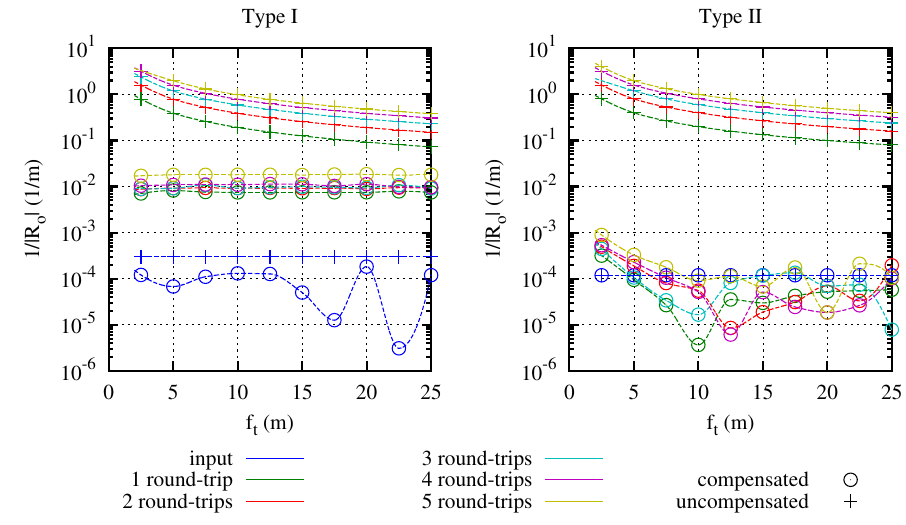
Figure 3. Inverse absolute value of the radius R o as a function of the focal width of a thermal lens f t for compensated and uncompensated relay imaging systems with 5 round-trips. Results were derived from ray-tracing simulation. Values small than 10 − 3 1 / m can be considered as numerical